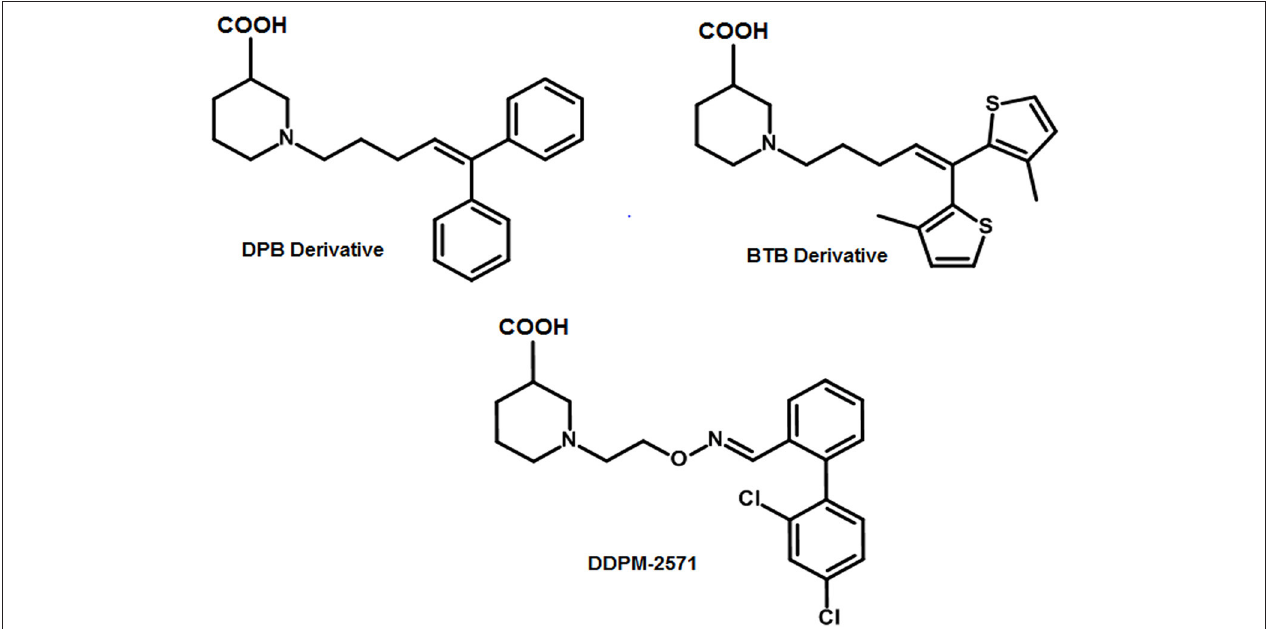
FIGURE 8 | Examples of N-substituted nipecotic acid derivatives for the inhibition of GAT1 with DDPM-2571 (pIC 50 = 8.29 ± 0.02) having pIC 50 value comparable to the Tiagabine (7.43 ±